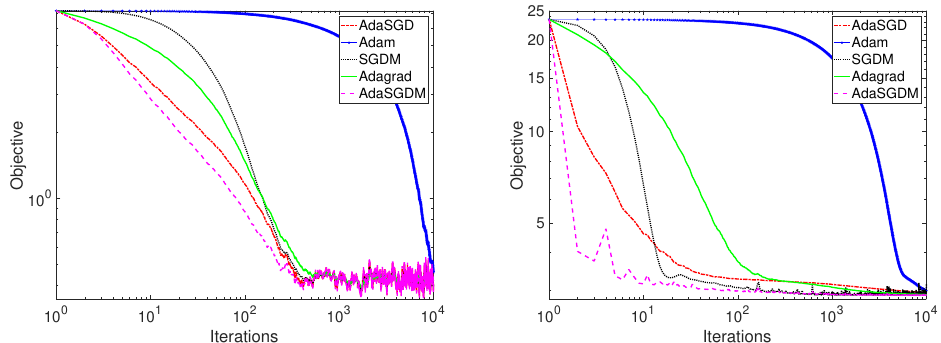
Figure 3. The convergence paths of the algorithms SGDM, Adam, and Adagrad and the proposed methods AdaSGD and AdaSGDM when m = 60, n = 10, and the objective functions are smooth non-convex functions. Left : the objective function f 3 ( x ); Right : the objective function f 4 ( x ) .